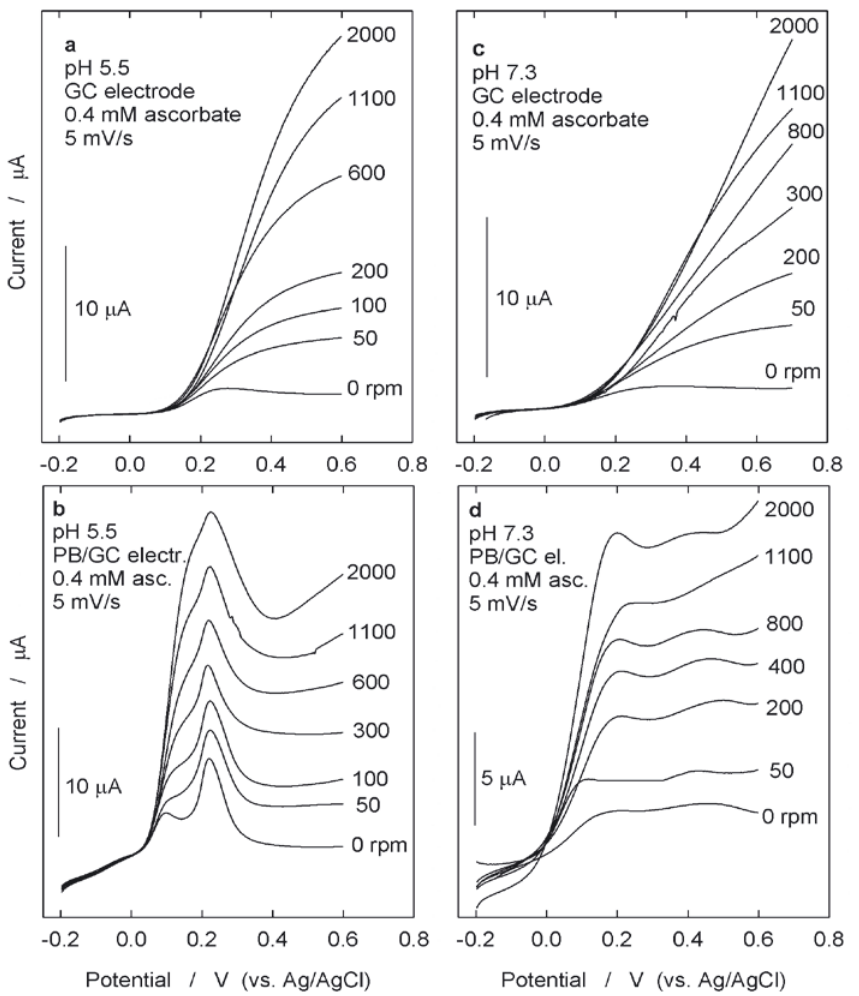
Figure 1. Slow potential sweep (5 mV s -1 ) voltammograms, obtained in pH 5.5 (a, b), and pH 7.3 solutions (c, d) containing 0.4 mM of ascorbate, at a glassy carbon (a, c), and Prussian blue modified glassy carbon electrodes (b, d) at different electrode rotation velocities (as